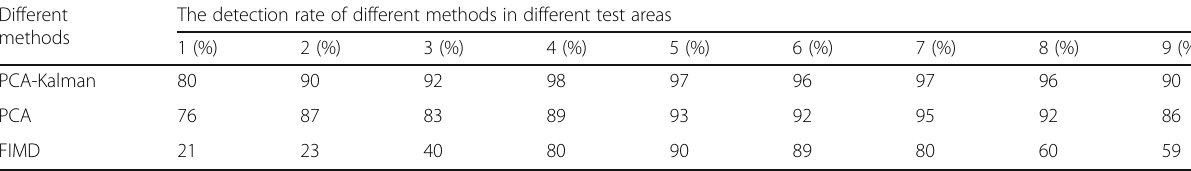
Table 4 The detection rate of different methods in different test areas Different methods